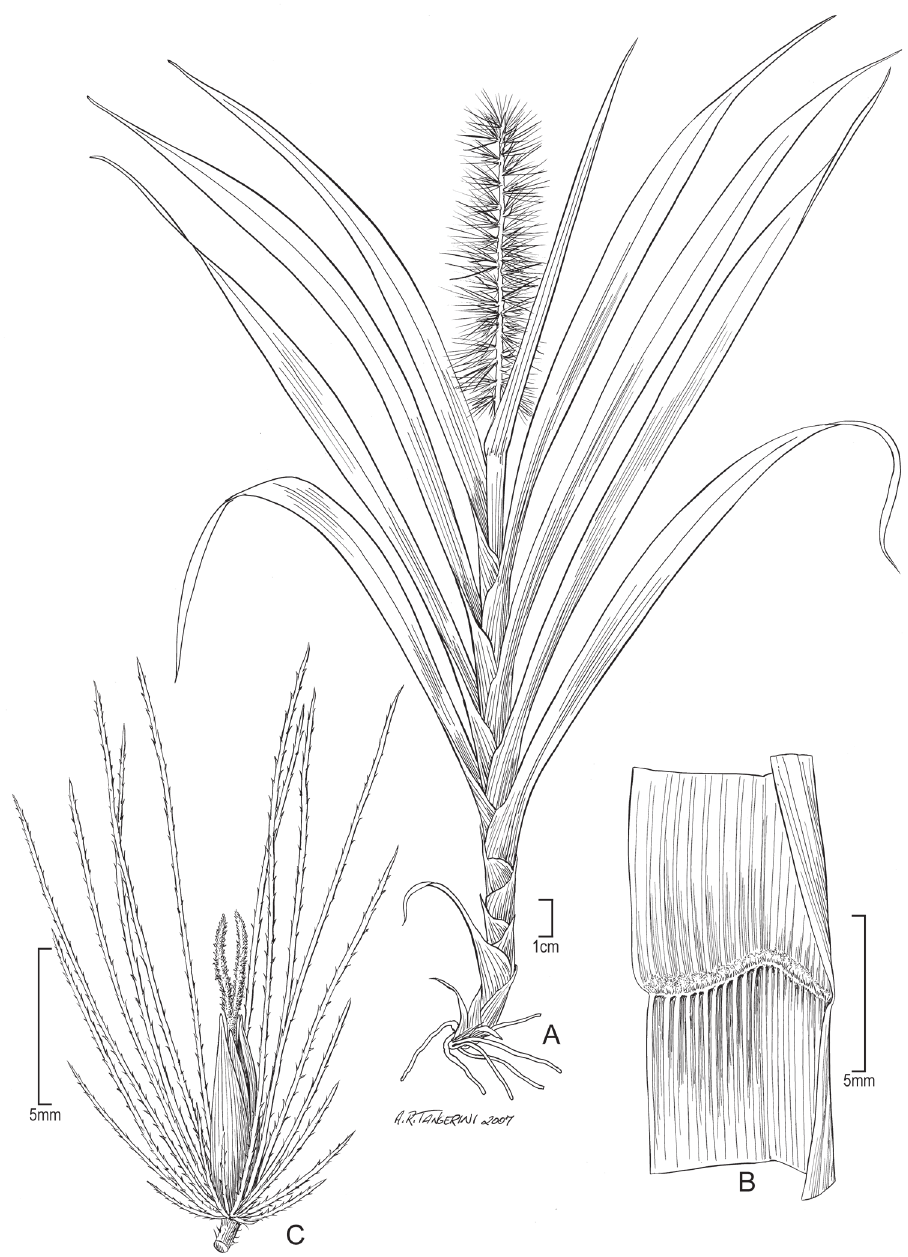
Figure 2. Cenchrus henryanus (F. Br.) M. Tornabene & W.L. Wagner A Habit B Ligule C spikelet. Drawn from Perlman 10106 (US). Illustration by Alice